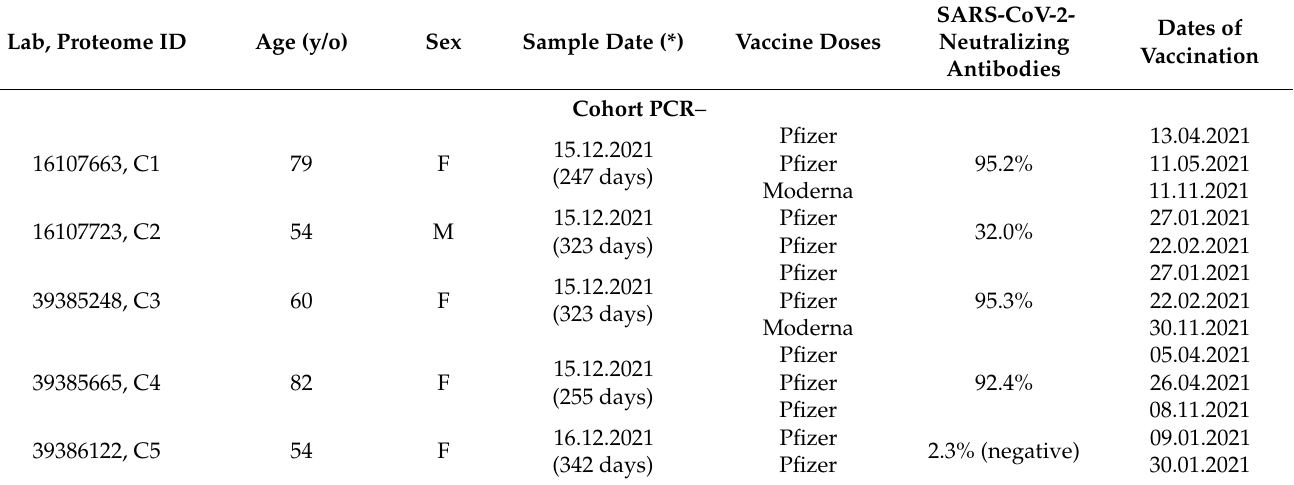
Table 1. Data on serum samples included in the